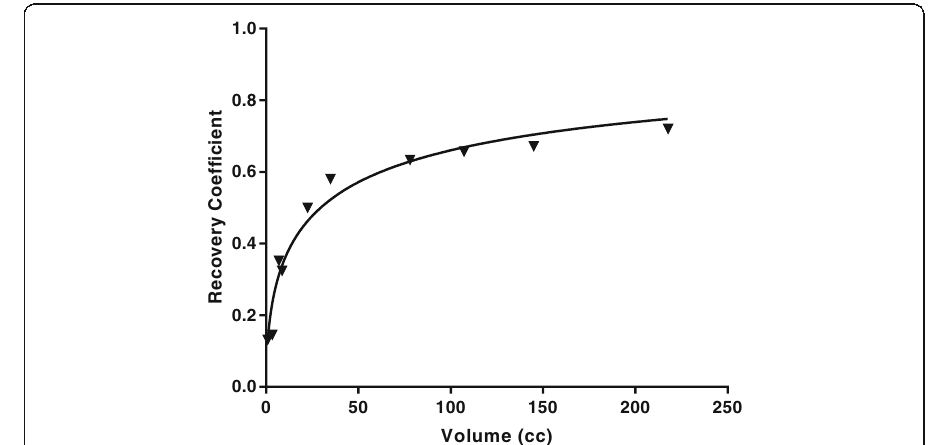
Fig. 4 System recovery curve for 131 I derived from different-sized cylindrical